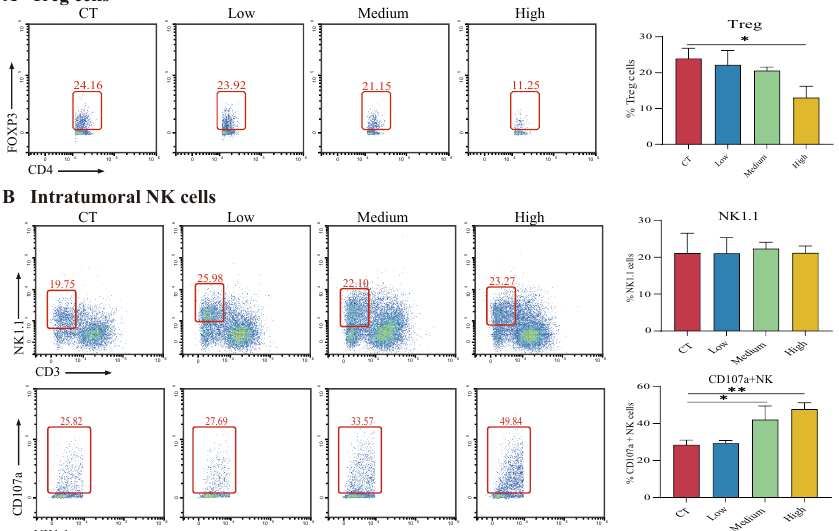
Figure 10. TAX modulates immune cells in the tumor microenvironment in vivo: ( A , B ) Changes of Treg cells and NK cells in the tumor microenvironment. ns, not significant, * p < 0.05, ** p < 0.01. (Student’s t -test). Data are presented as mean ±